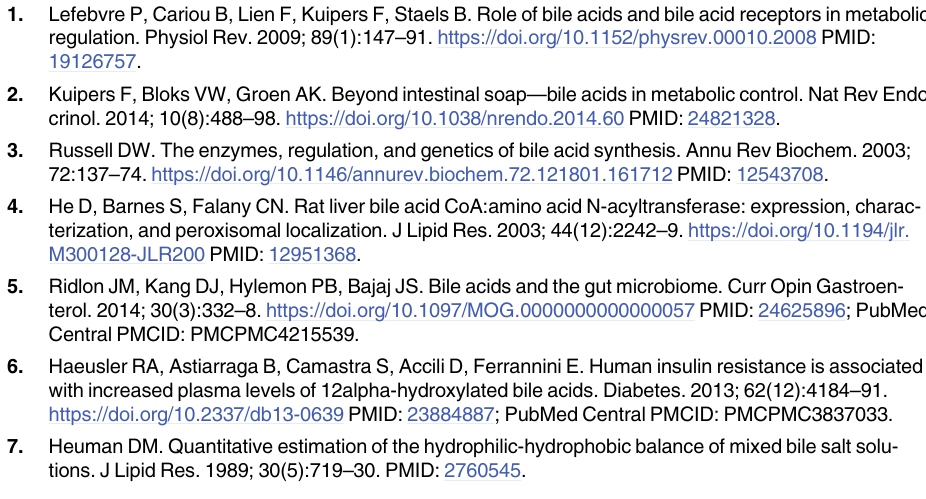
S2 Fig. DCA supplementation does not impact food intake, body weight or adiposity in mice used for assessment of in vivo glucose regulation. Energy intake (days 1–32, A), body weight (B) and adipose depot weights (subcutaneous (SQ), mesenteric (Mes), epididymal (Epi), retroperitoneal (RP) and brown adipose tissue (BAT)) (C) in mice used for ITT and OGTT tests. Data are expressed as mean ± SEM, n = 8 per